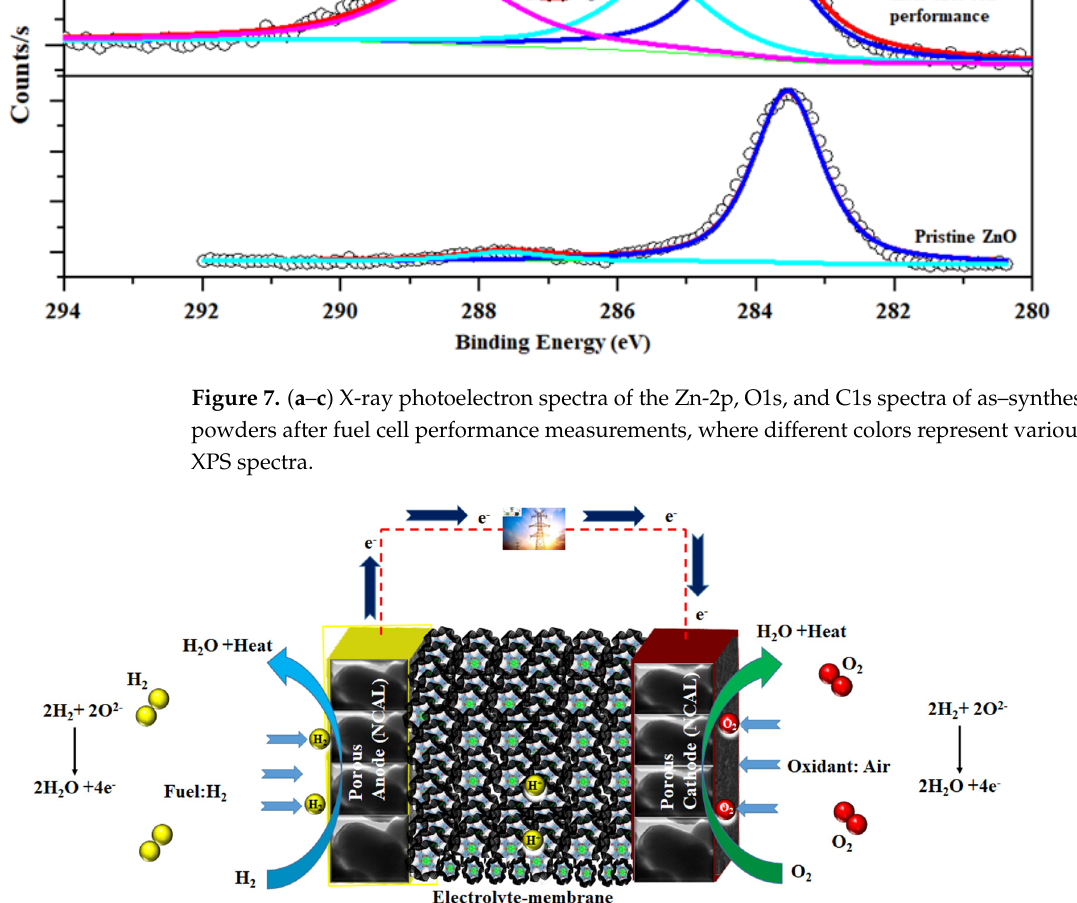
Figure 8. The electrochemical processes involved in the phase transition of ZnO to deficient ZnO for ionic transport in the operation of a zinc − oxide-based fuel cell.